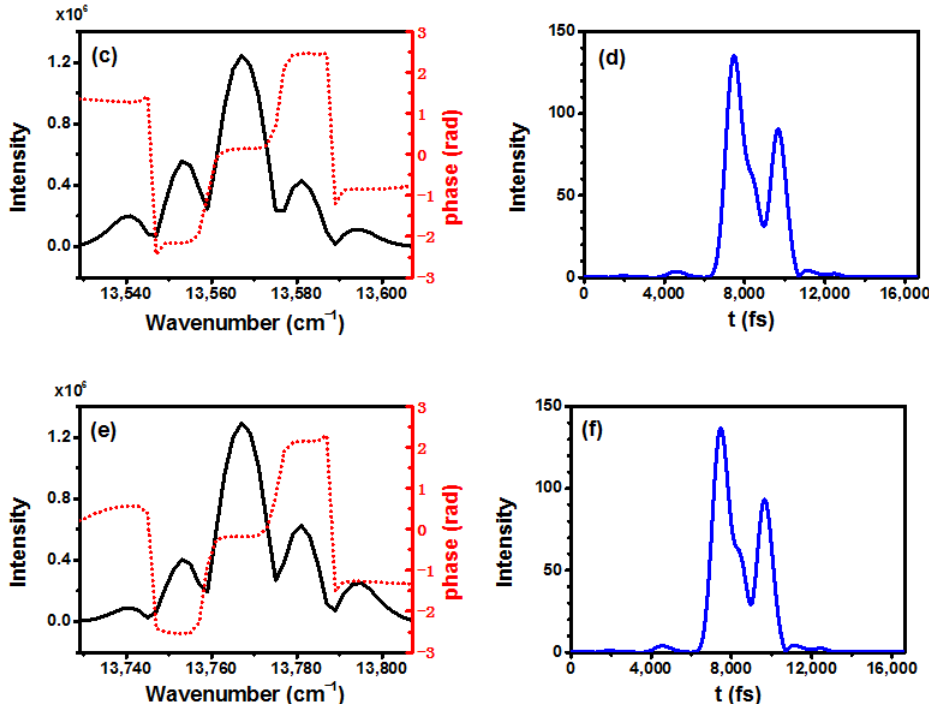
Figure A3. Frequency, phase, and time distribution of the three anti-Stokes pulses: ( a , b ) pf1, ( c , d ) pf2, and ( e , f ) pf3.